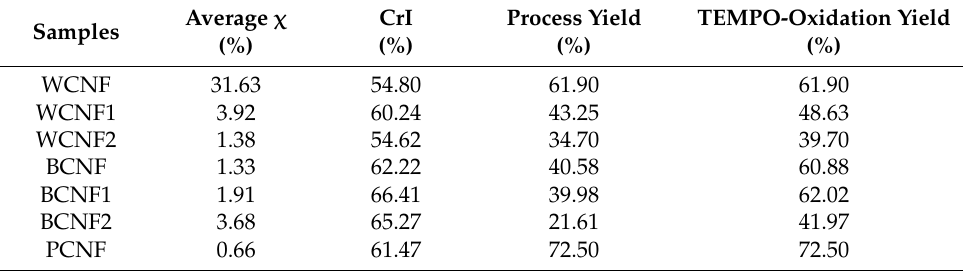
Figure 5. The optical properties and thermal stability of different TEMPO-oxidized CNFs films. ( a ) The transmittance, ( b ) the diffusive optical transmission properties, ( c ) TG and ( d ) DTG curves. Table 2. Scattering transmission parameter, crystallinity index and yield data of the CNFs.